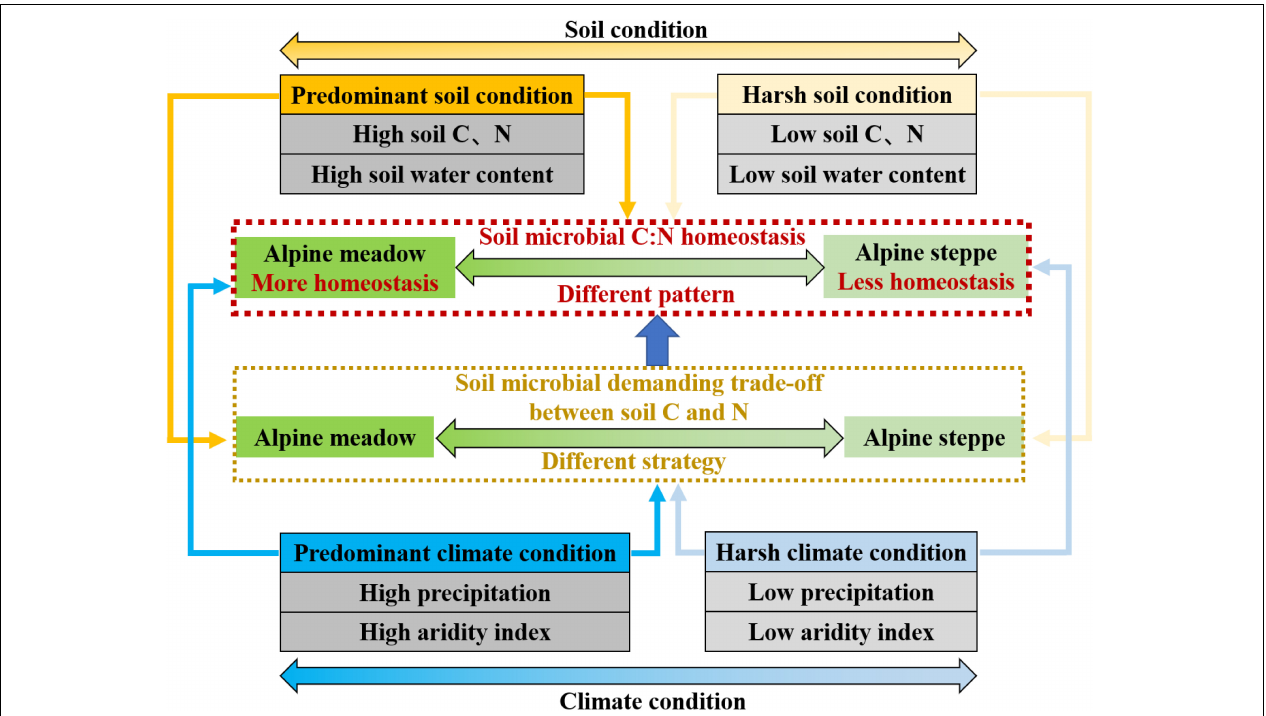
FIGURE 7 | Conceptual model of soil microbial biomass stoichiometry C:N homeostasis in arid (alpine steppe) and humid (alpine meadow) environments. Soil microbes tend to be less homeostatic in their C:N stoichiometry under harsh climate (low precipitation and aridity index) and soil (low soil C and N and low soil water content) condition in alpine steppe. Conversely, soil microbial C:N stoichiometry is more homeostatic under better climate (high precipitation and aridity index) and soil (high soil C and N and high soil water content) condition in alpine meadow. Furthermore, demanding trade-off of soil microbial strategy between soil C and N responding to climate and soil factors is different, leading to different homeostasis pattern of soil microbes between alpine meadow and